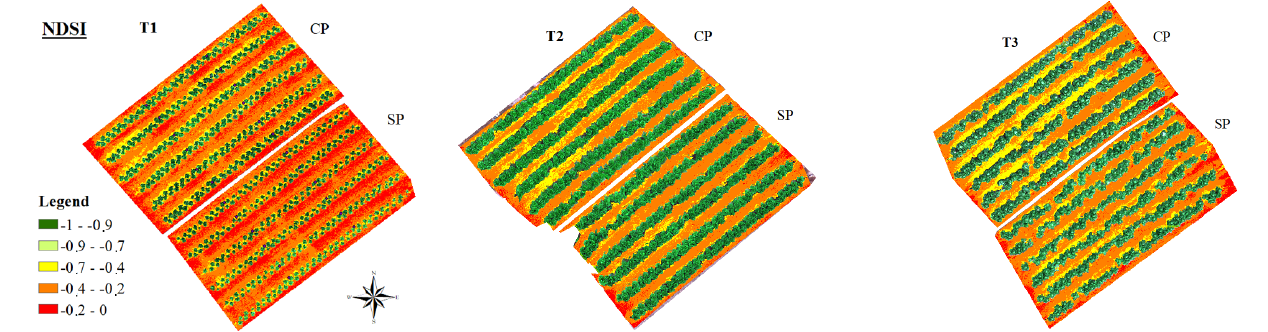
Figure 5. NDSI maps applied to bare soil for T1, T2, and T3.